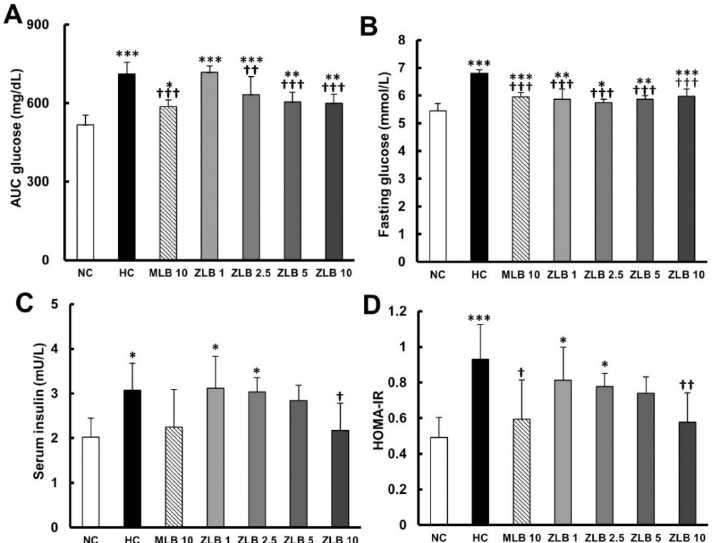
Figure 5. Effects of MLB and ZLB on glucose metabolism . The glucose tolerance test was carried out three weeks after administration of MLB or ZLB. The levels of blood glucose were measured every 30 min for 2 h, and the area under the curve (AUC) of the blood glucose curve is depicted ( A ). The levels of fasting blood glucose ( B ) and insulin ( C ) were measured at the end of the experiment (4 weeks). The homeostatic model assessment for insulin resistance (HOMA-IR) data were calculated and depicted ( D ). NC, normal diet control; HC, high-fat-diet (HFD) control; MLB10, HFD with 10 mg/kg/day of MLB; ZLB1, ZLB2.5, ZLB5, and ZLB10, HFD with 1, 2.5, 5, and 10 mg/kg/day of ZLB. Values are expressed as mean ± SD (n = 6 per group). * P < 0.05, ** P < 0.01, and *** P < 0.001 vs. NC group; † P < 0.05, †† P < 0.01, and ††† P < 0.001 vs. HC group.